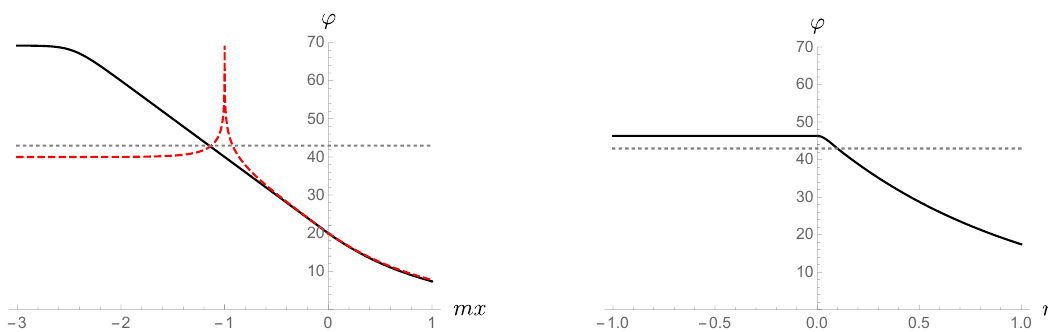
Figure 10. Left: profiles of the Hartle-Hawking sphaleron (black solid) and a slice of periodic instanton at τ = 0 (red dashed) for λ = 0 . 5Λ . The center of the periodic instanton is taken at HH x HH = − 1 /m . The grey dotted line marks the field value ϕ max corresponding to the top of the √ potential barrier, see figure 5. We take ln( m/ κ ) = 20 . Right: high-temperature sphaleron for the same model